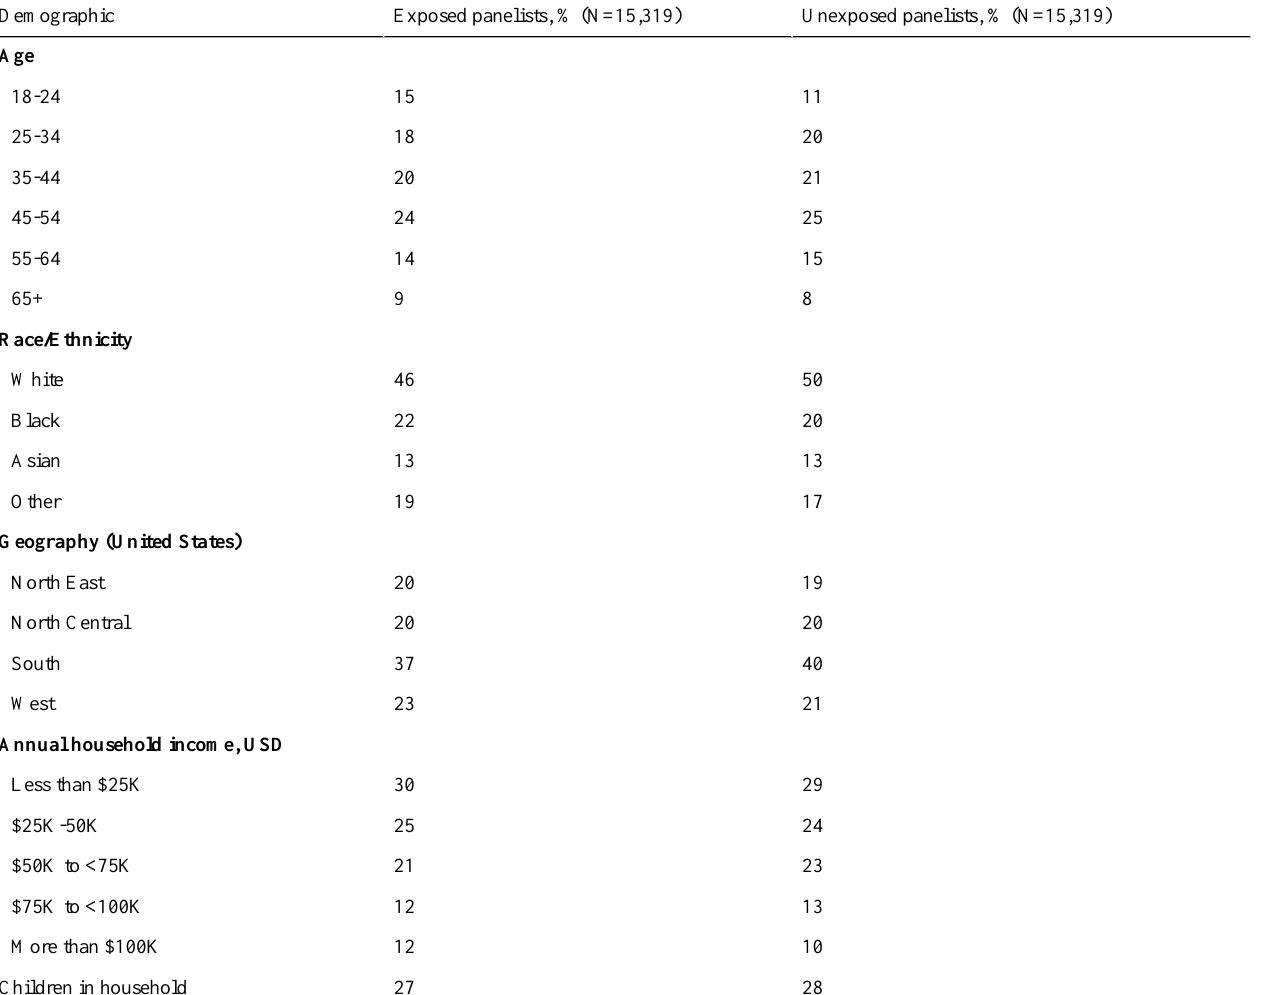
Table 1. Demographic characteristics of exposed and unexposed